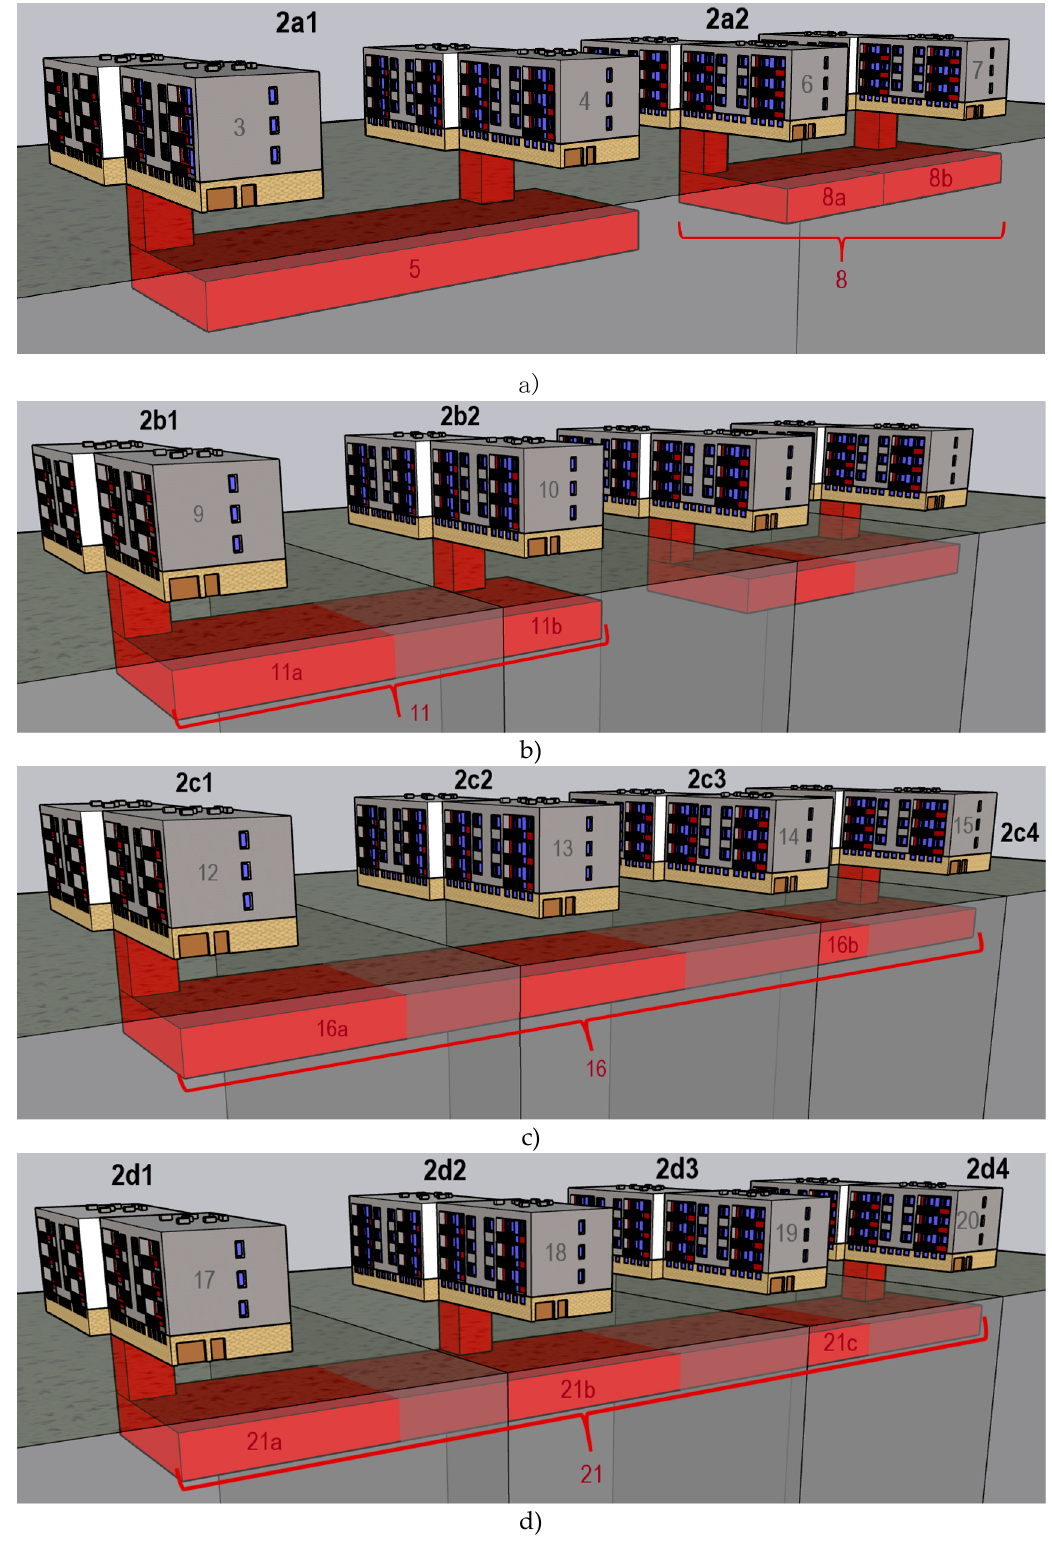
Figure 13. Possible cases of access to (an) underground object(s): a) underground part is the object within one property, b) underground part is divided between two properties, c) underground part is divided between two properties having access to it, d) underground part is divided between properties having access to it (in this case three properties) . Source: own study.